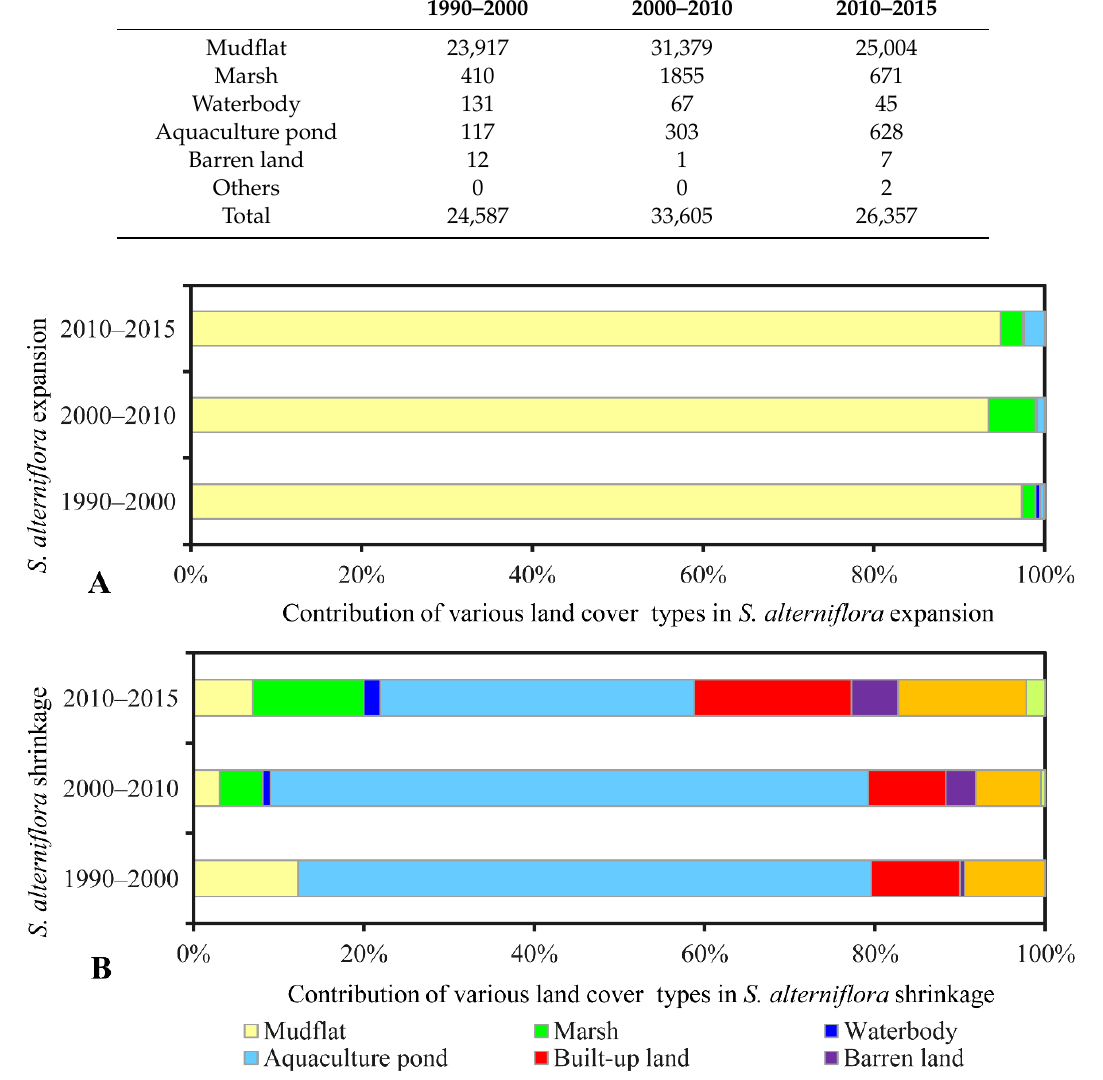
Figure 5. Contribution of various land cover types in S. alterniflora changes during different periods (contribution was calculated by area ratio): ( A ) expansion, ( B ) shrinkage.